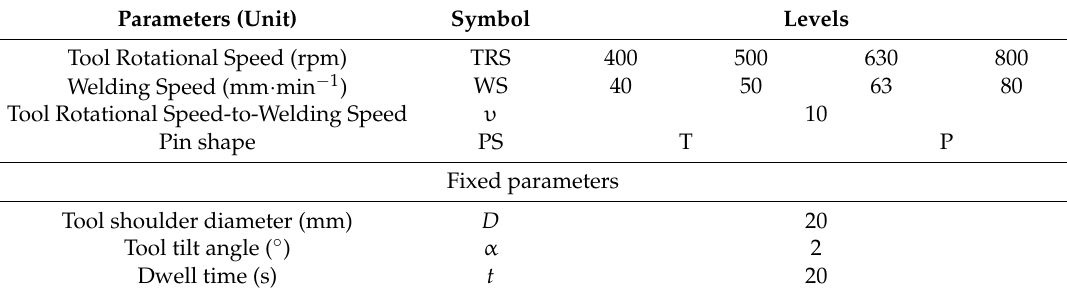
Table 3. FSW process parameters and their levels.